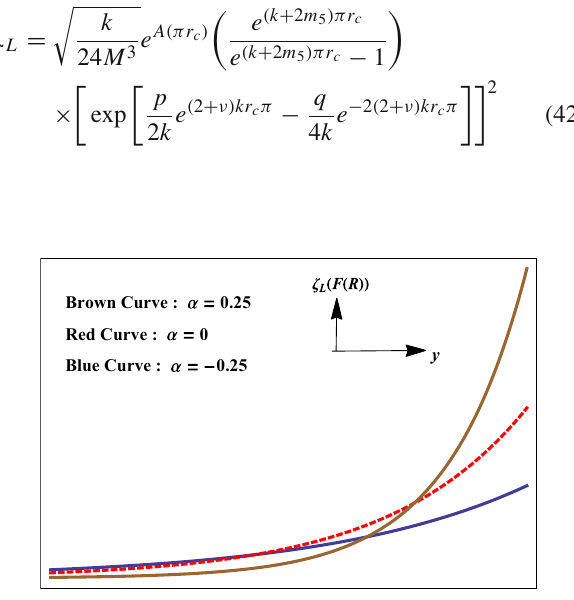
Fig. 2 ζ L ( = ζ L ( F ( R )) in the diagram) vs. y for M = 1, (cid:9) = − 1 and m 5 = 0 . 5